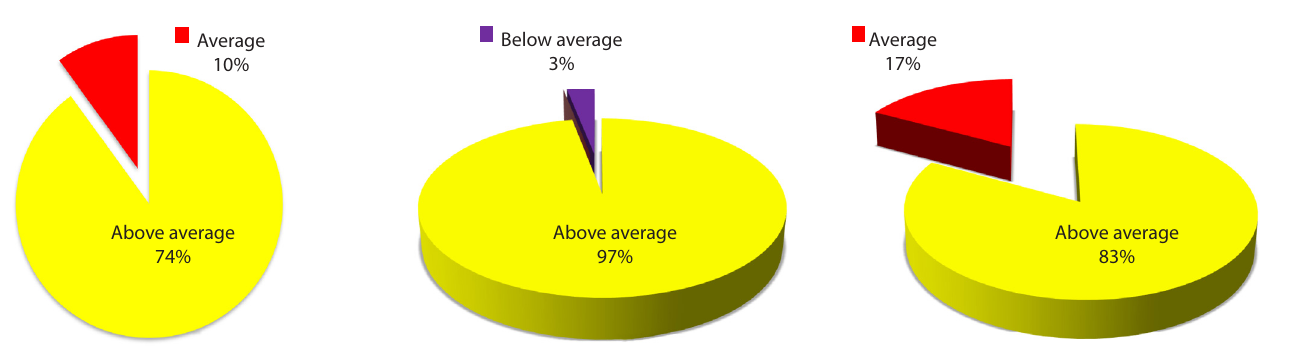
Fig. 3.7 - Overall score of the three- dimensional heart model.